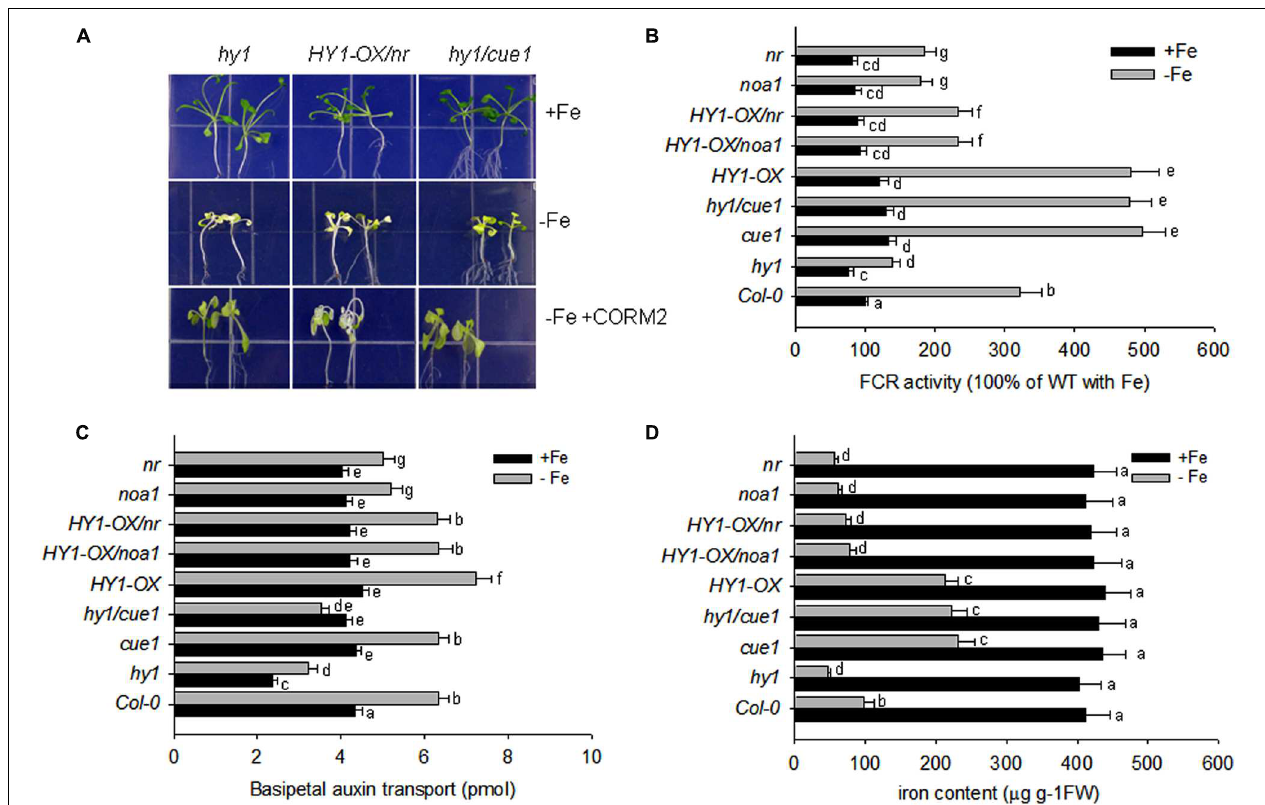
FIGURE 7 | Auxin and CO modulate the response to –Fe stress in Arabidopsis . (A) The phenotypes of hy1 , HY1-OX/nr, and hy1/cue1 mutants grown on + Fe, –Fe, or –Fe + CORM2 media for 1 week. All lines were first grown on + Fe media for 2 weeks and then subjected to the specified treatment for 1 week. Lines kept on + Fe media were used as the positive control. (B–D) FCR activity, Fe content, and root basipetal auxin transport in the wild-type Col-0, hy1, and HY1-OX lines upon exposure to –Fe stress. The wild-type Col-0, hy1 , and HY1-OX lines were grown on + Fe media for 2 weeks and then shifted to –Fe media (–Fe), or + Fe media ( + Fe) for 1 week before measurements were taken. The FCR activity (B) , Fe content (C) , and basipetal auxin transport (D) were measured after 1 week of –Fe stress. Data are the means ± SD ( n = 12), and bars with different letters are significantly different at p < 0.05 (Tukey’s